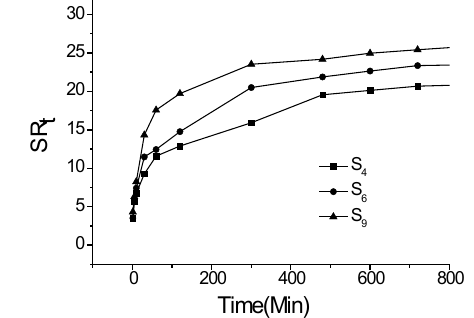
Figure 5. The effect of different cross-linker contents on the swelling kinetics of PNIPAAm hydrogels in distilled water at 25°C.